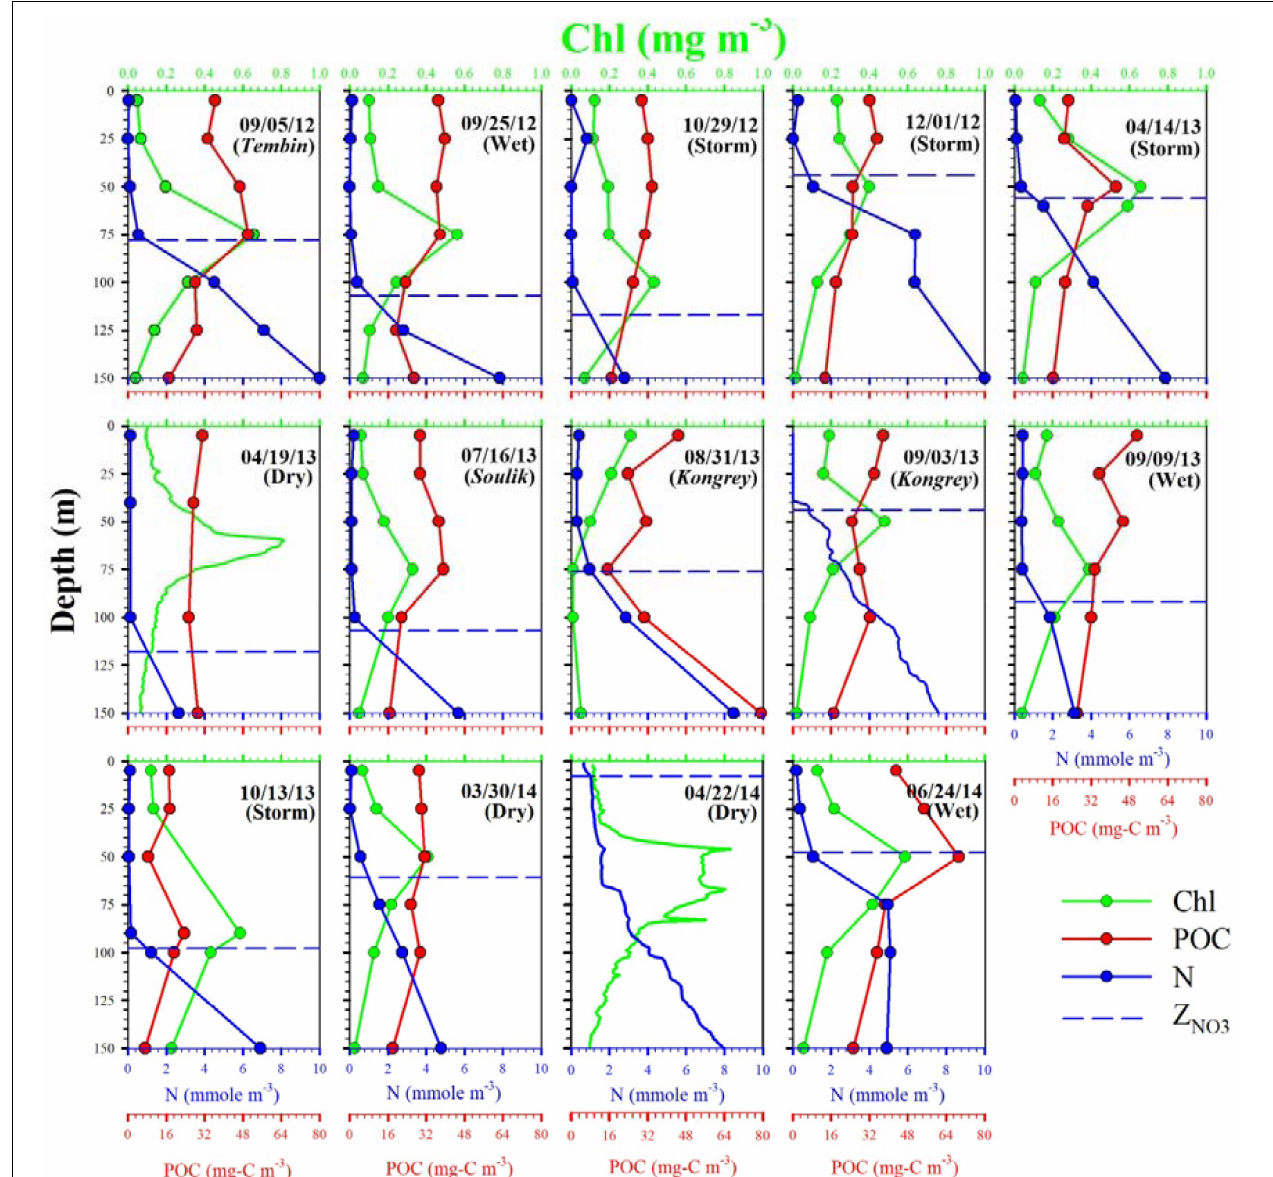
FIGURE 3 | Vertical profiles of Chl, N, and POC for each sampling date (mm/dd/yy). The horizontal blue dash line represents the depth of the nitracline (Z NO3 ) for each cruise. Since part of the data on 19 April, 3 September 2013, and 22 April 2014 was not available, linear relationships (see section “Materials and Methods”) between fluorescence and Chl, temperature and N were employed to calculate vertical distributions of Chl and N. Wet and Dry denote those sampling dates that occurred during the wet and dry seasons but under non-typhoon and non-storm conditions, respectively.